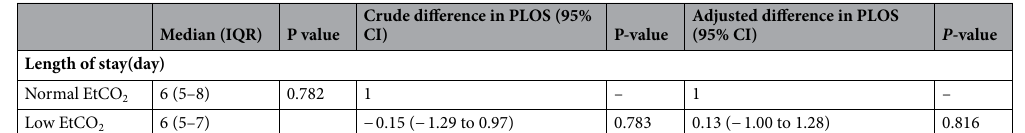
Adjusted difference in PLOS (95% CI) P